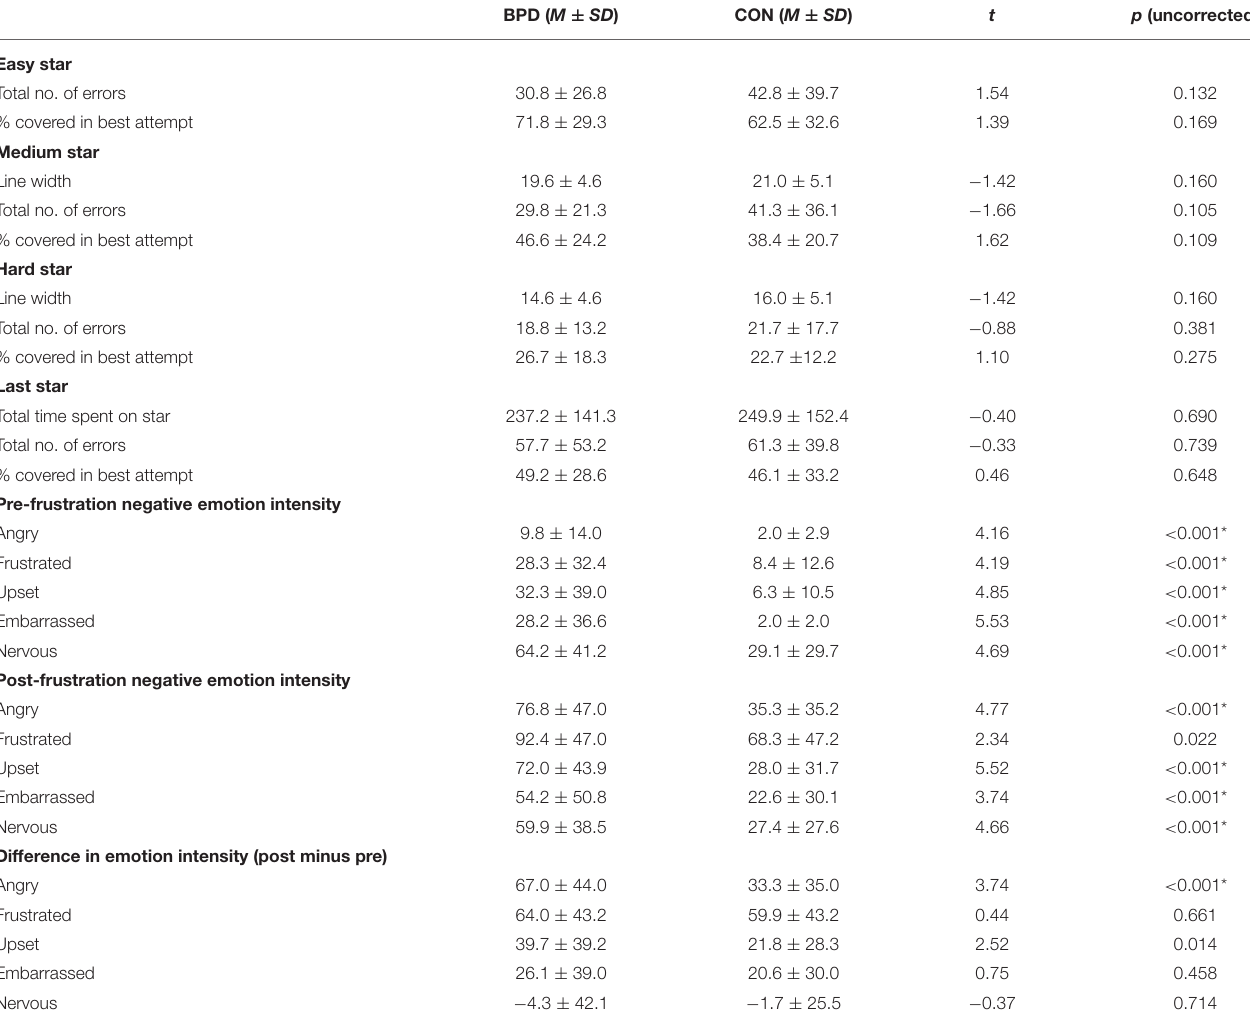
TABLE 2 | Task performance and level of frustration at all four stars (easy, medium, hard, and last